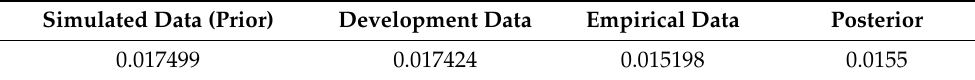
Table 3. PD estimator